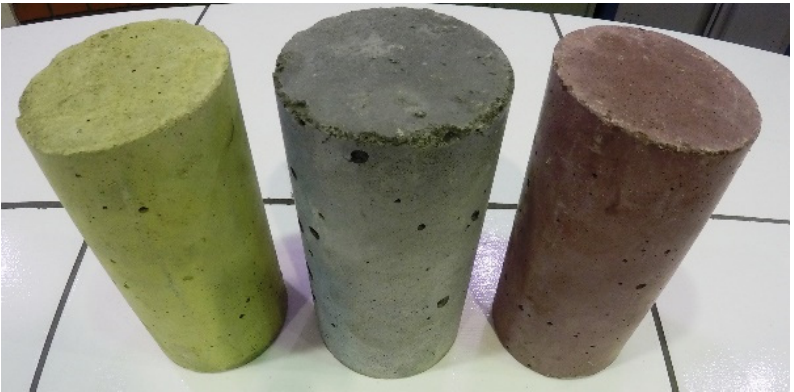
Figure 1. Colored concretes used in the paper: 16 MPa in yellow, 54 MPa in blue, and 85 MPa in